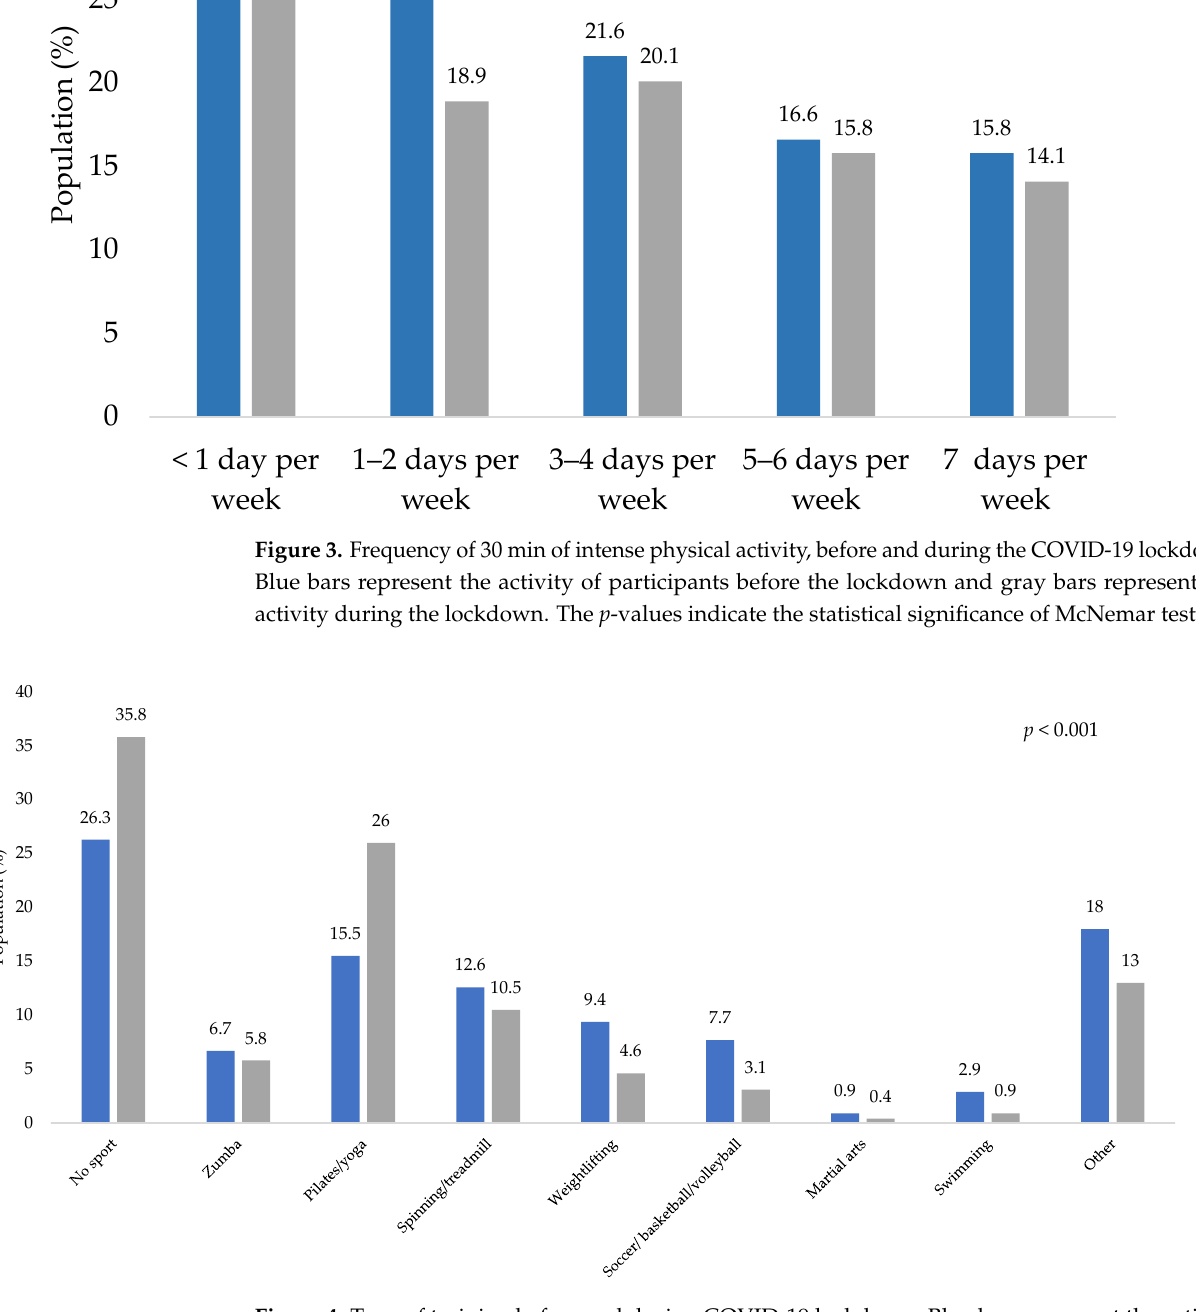
Figure 4. Type of training before and during COVID-19 lockdown. Blue bars represent the activity of participants before the lockdown and gray bars represent the activity during the lockdown. The p -values indicate the statistical significance of the McNemar test.